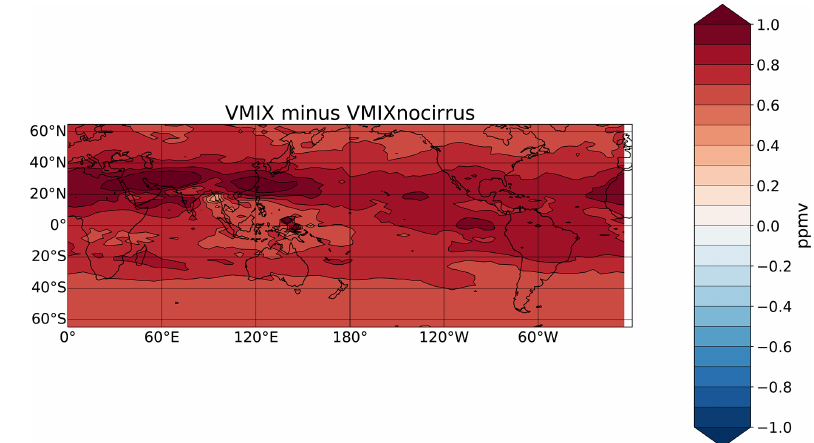
Figure A2. Differences in the distribution of water vapour at 100hPa between VMIX (experiment with ice microphysics) and VMIXnocirrus (experiment without ice microphysics) during JJA for 2005–2008. Red colours mean VMIX performs larger water vapour than VMIXnocir- rus.